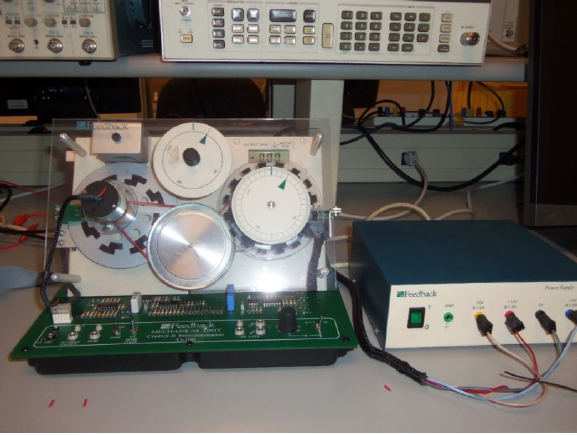
Figure 2. Servo mechanism plant with power supply